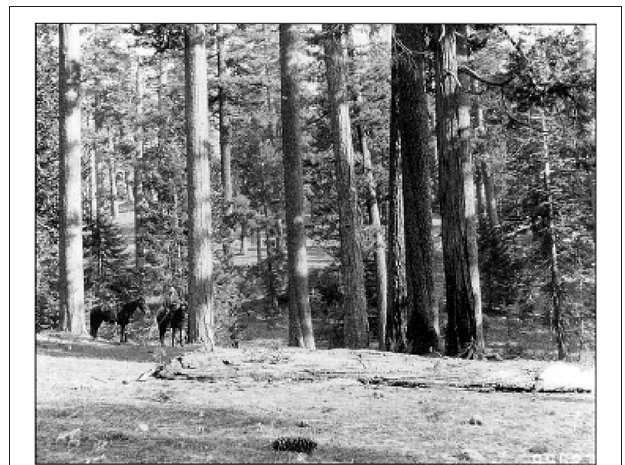
FIGURE 6 | Tahoe National Forest July 1911. Sugar ( Pinus lambertiana ) and ponderosa pine ( Pinus ponderosa ). Note open understory attributed to Indigenous burning and sheep grazing (McKelvey and Weatherspoon,